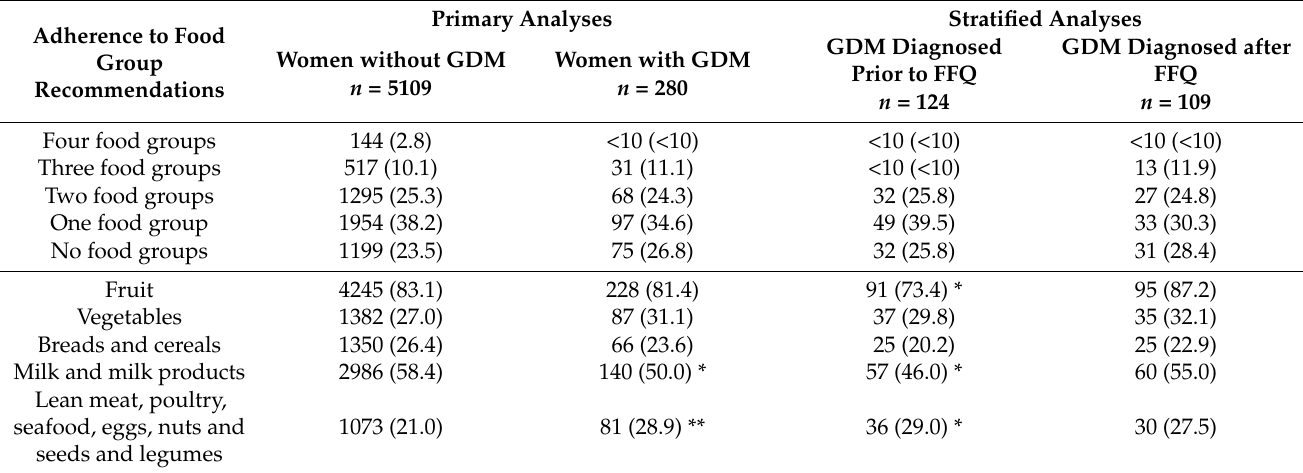
Table 2. Adherence to Ministry of Health food group